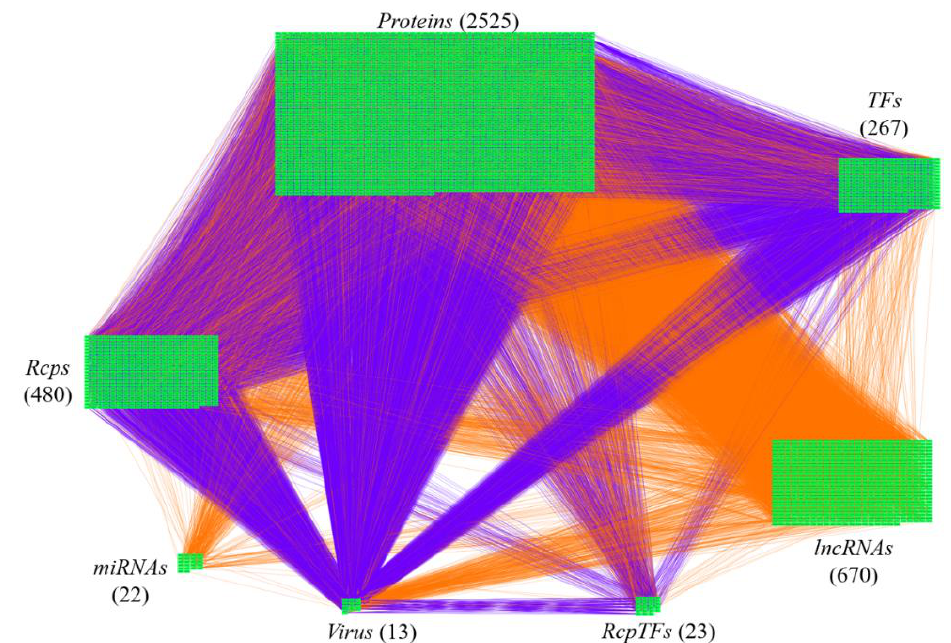
Figure 2. The core host-pathogen interspecies genome-wide genetic and epigenetic network (core HPI-GWGEN) of COVID-19-associated ARDS. Purple lines indicate the protein – protein interactions and orange lines denote the gene regulations. The node numbers of proteins, Rcps, TFs, RcpTFs, miRNA, LncRNA, Virus are 2525, 480, 23, 22, 670, and 13, respectively.